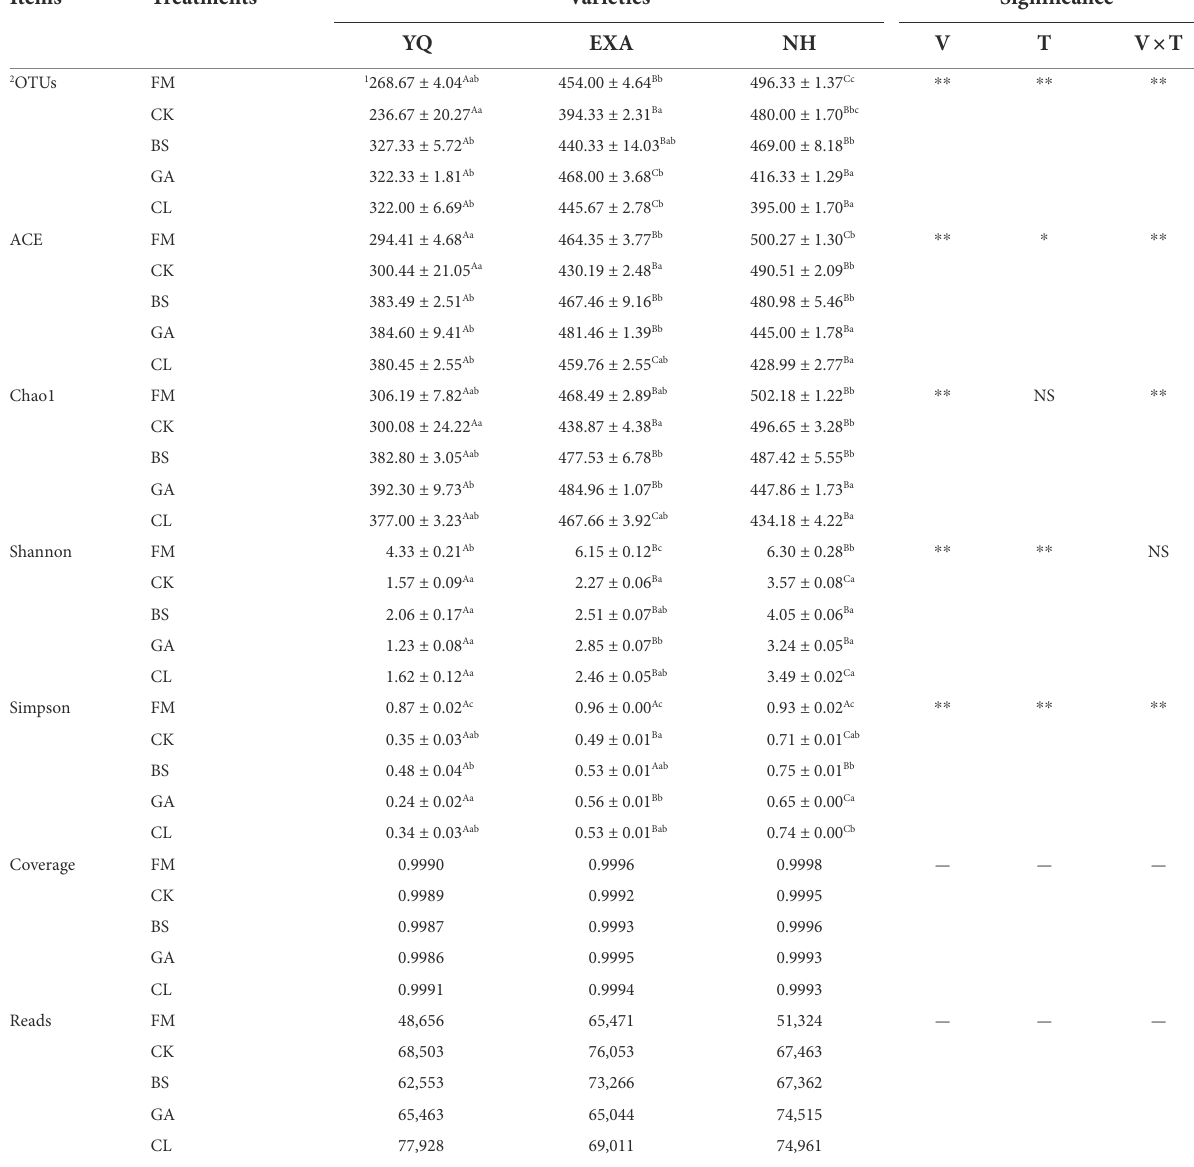
TABLE 5 Alpha diversity of bacterial communities in whole-plant corn silage with different treatments. Items Treatments